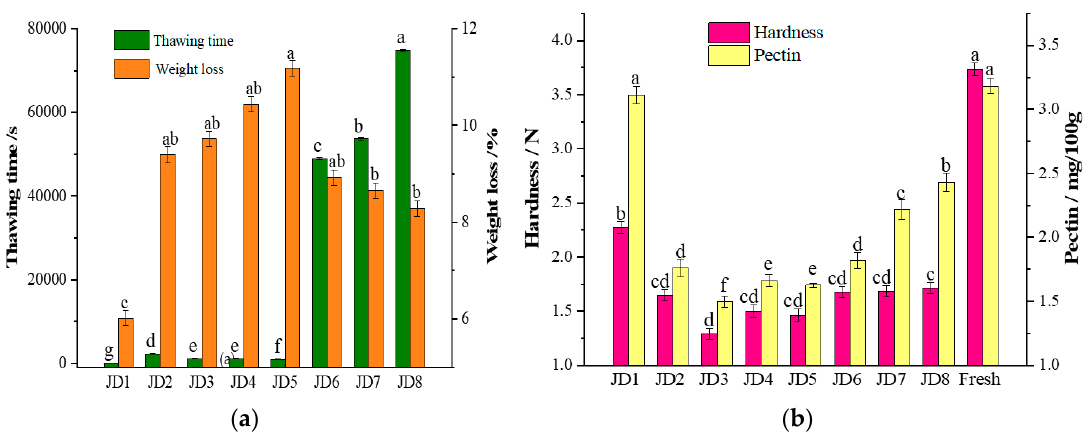
Figure 5. Effects of various thawing methods on the physical property changes of frozen blueberries: ( a ) thawing time and weight loss and ( b ) hardness and pectin.